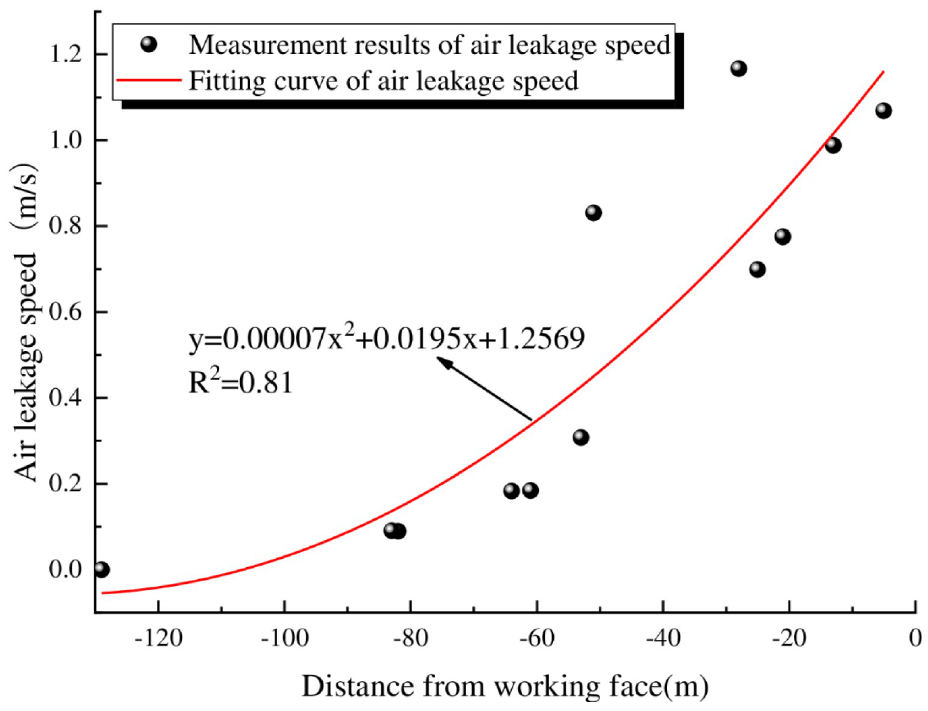
Fig 4. Predicted air leakage speeds at the working face of